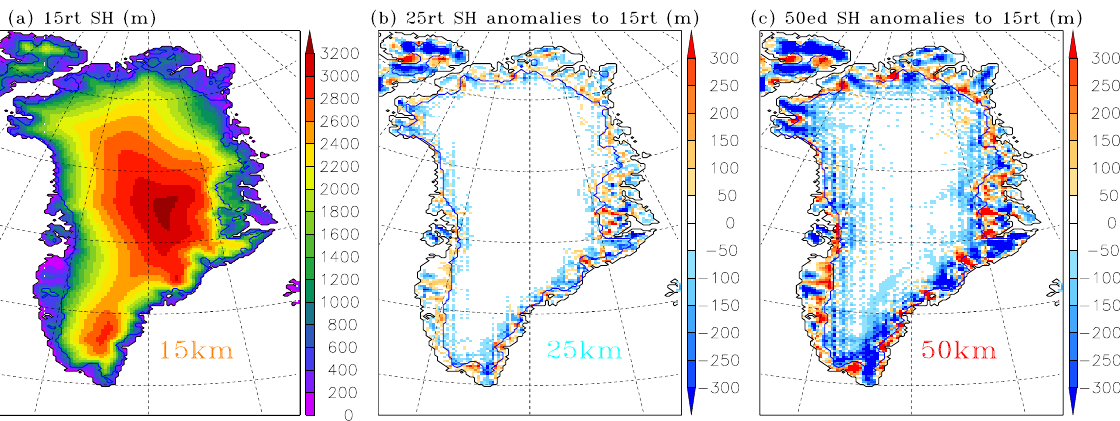
Fig. 3. (a) Surface height (m) of the MAR model at 15km resolution (15rt), with the 15km ice sheet mask drawn in solid blue line. (b– c) Surface height anomalies (m) of the 25 and 50km resolution surface height of the MAR model (25rt and 50ed) interpolated onto the 15km MAR grid, compared to (a) , with the ice sheet mask common to all the spatial resolutions drawn in solid blue line (see the Supplement for the 20, 30 and 40km surface height